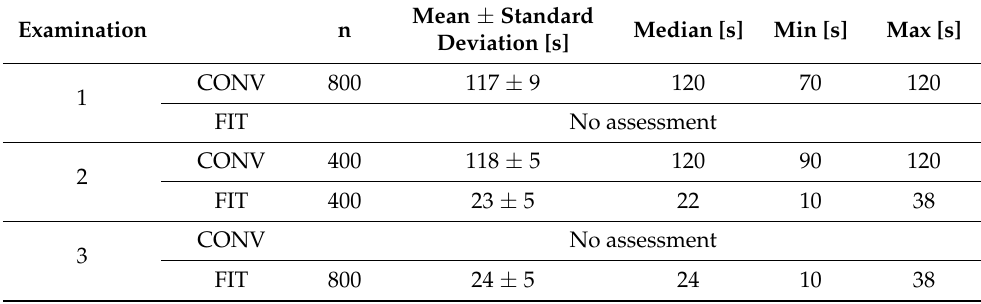
Table 3. Procedure time required for the identification of composite remnants by CONV vs. FIT.